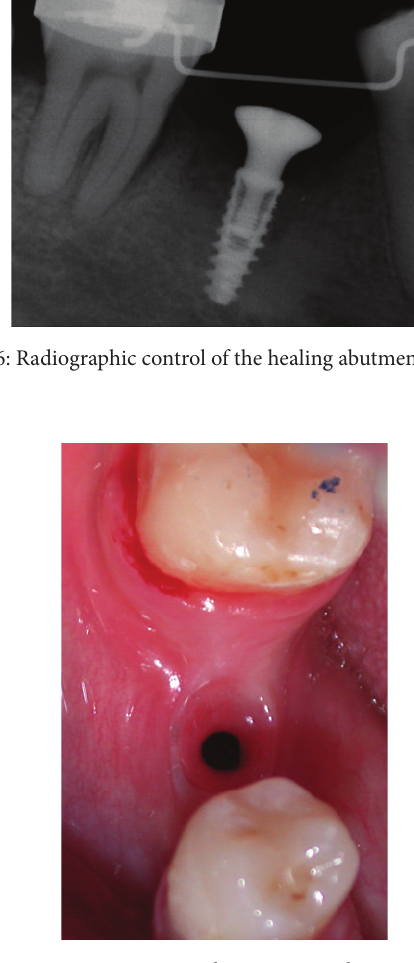
Figure 17: Provisional resin crown